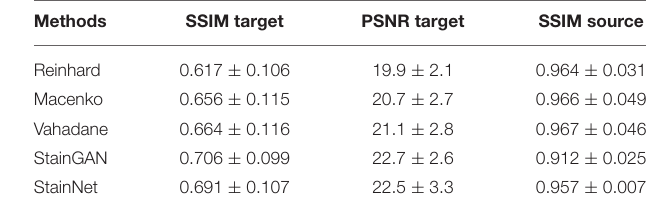
TABLE 1 | Evaluation metrics of various stain normalization methods on the cytopathology dataset.